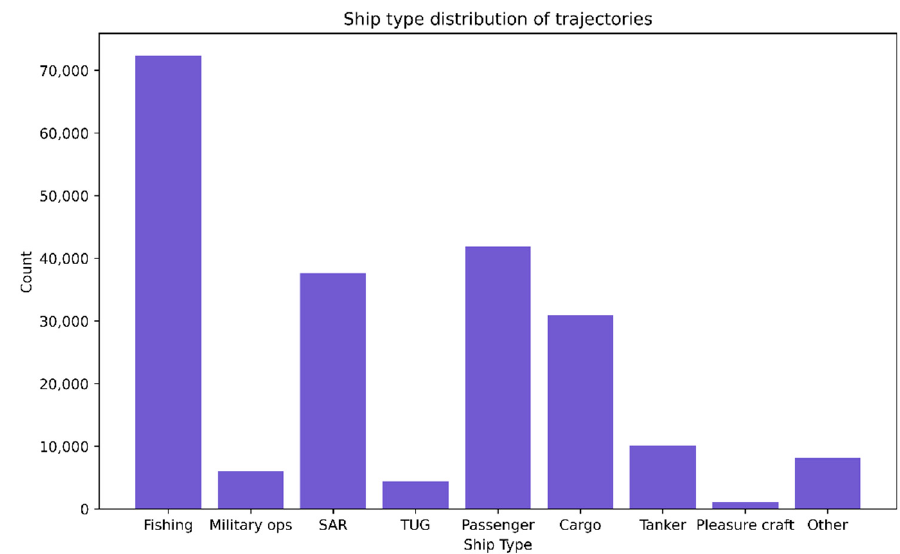
Figure 3. Ship type distribution of trajectories.